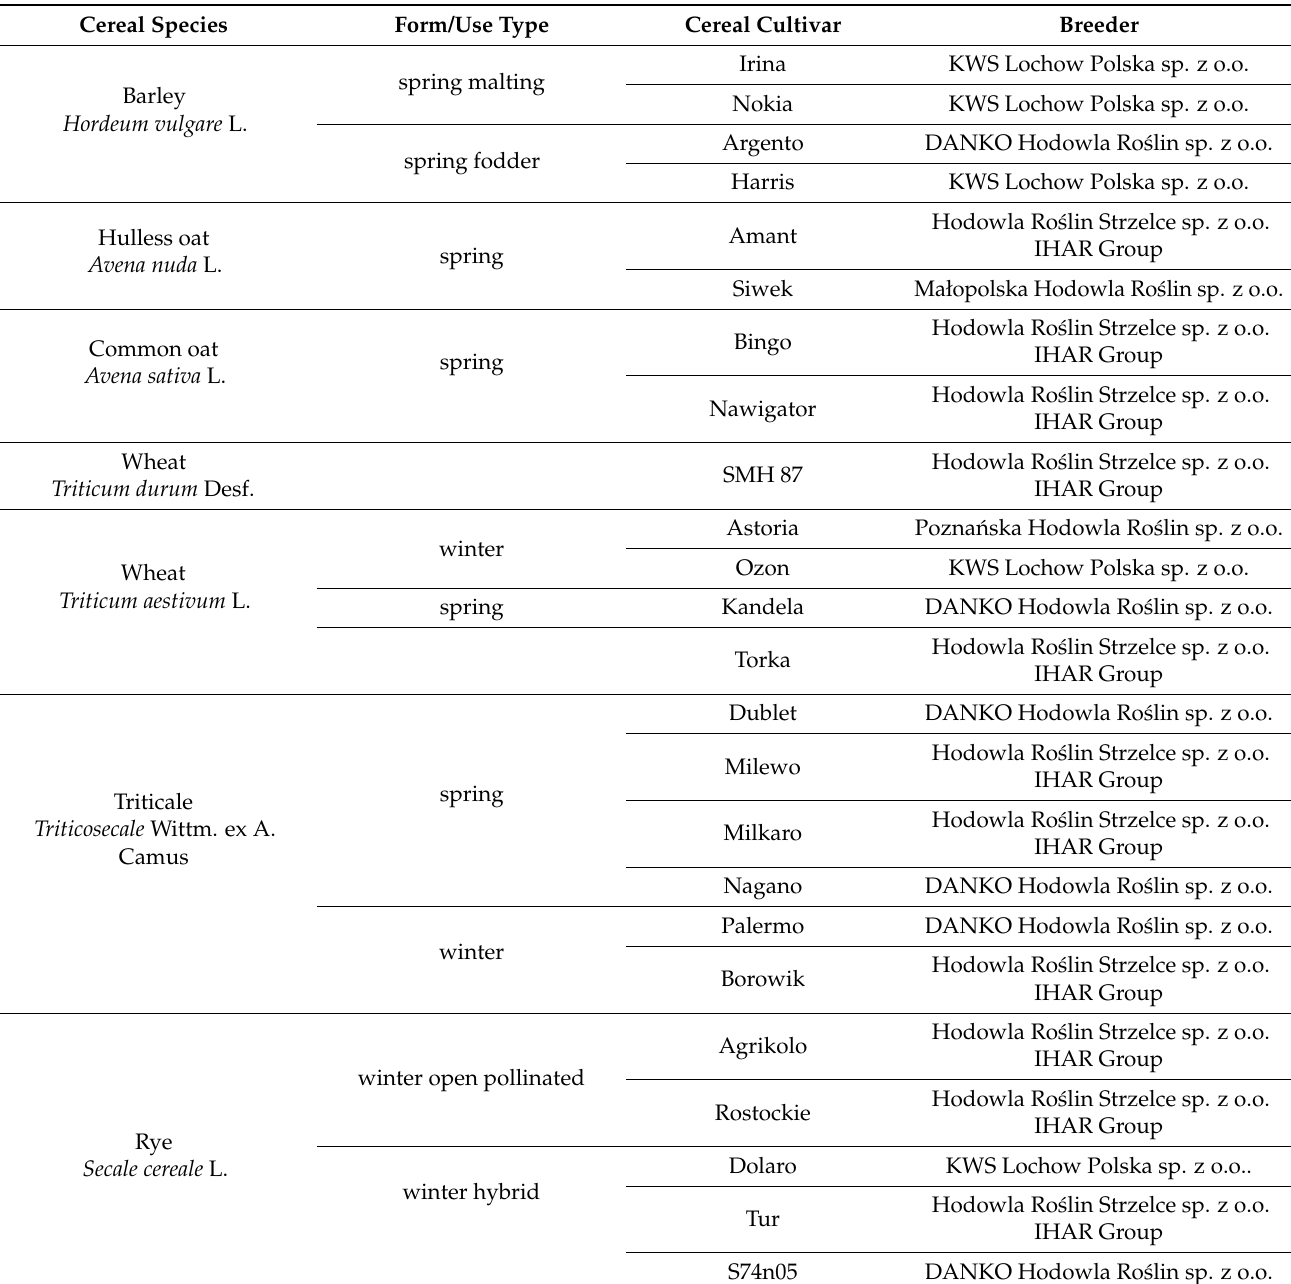
Table 2. Selected small-grained cereals grown at the Dło´n Experimental Agricultural Station in